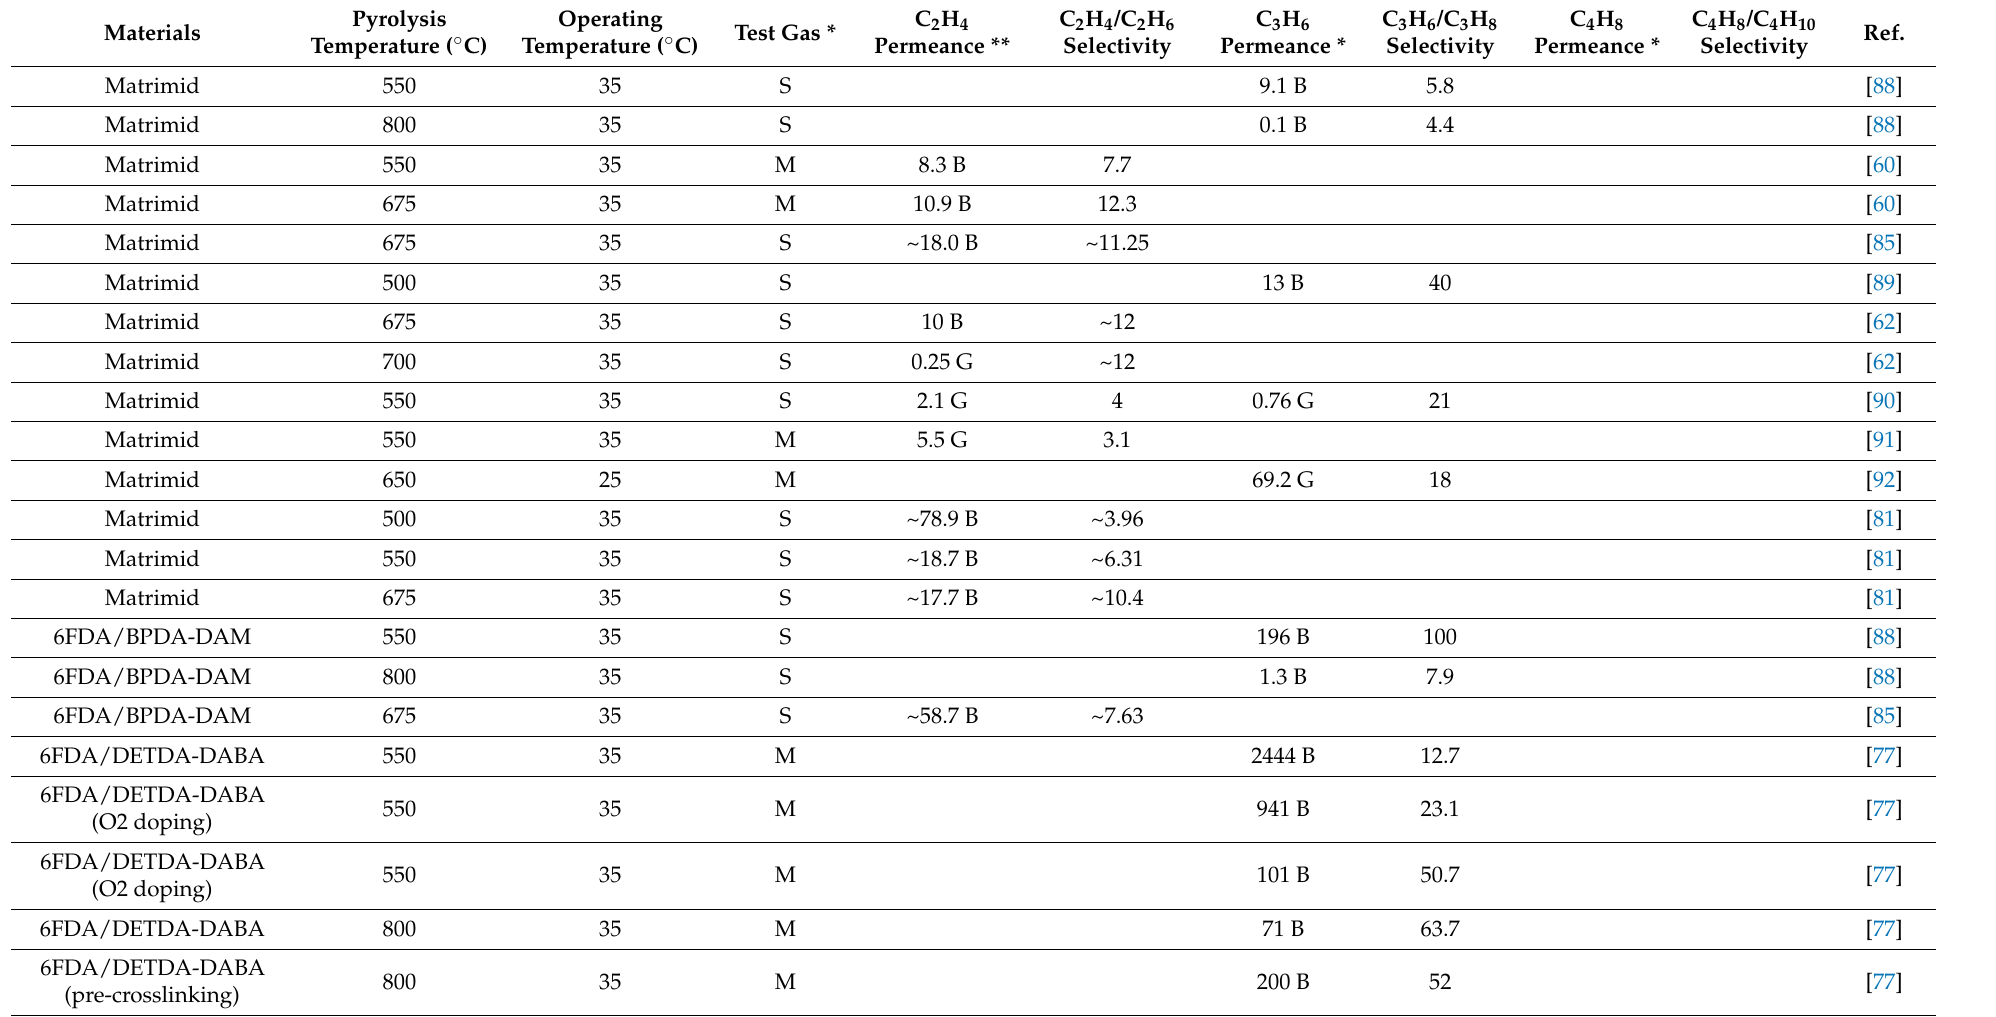
Table 2. Performance of CMS membranes for olefin/paraffin